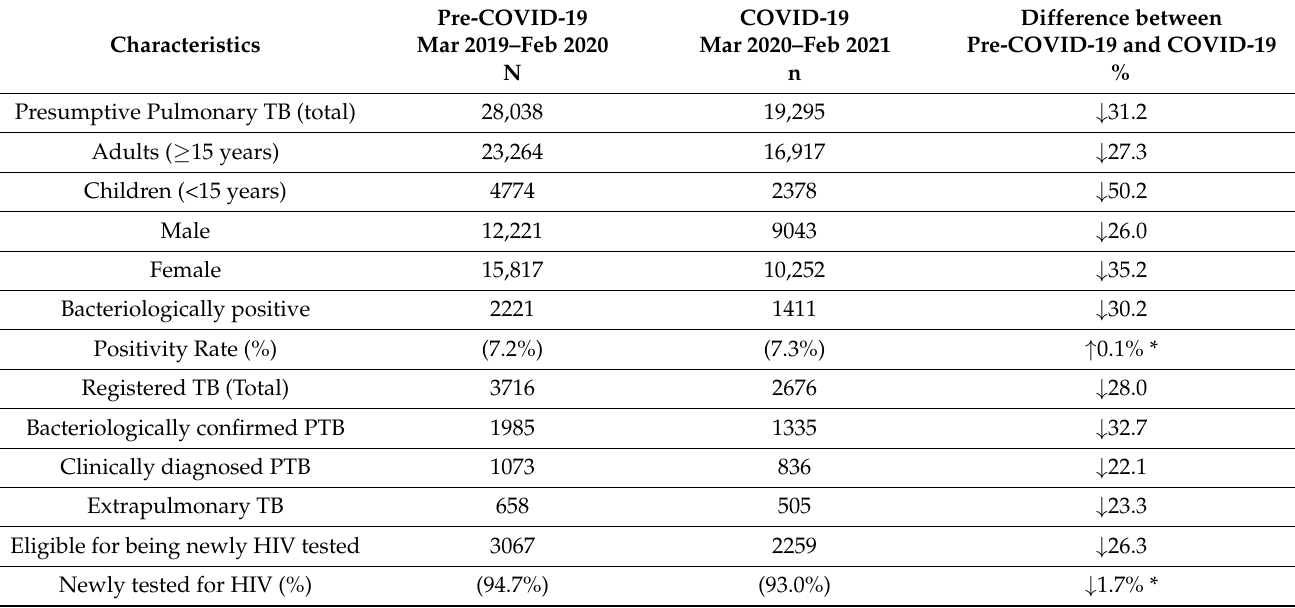
Table 1. Characteristics of persons with presumptive pulmonary TB and registered TB in 18 health facilities in Nairobi, Kenya, during pre-COVID-19 and COVID-19